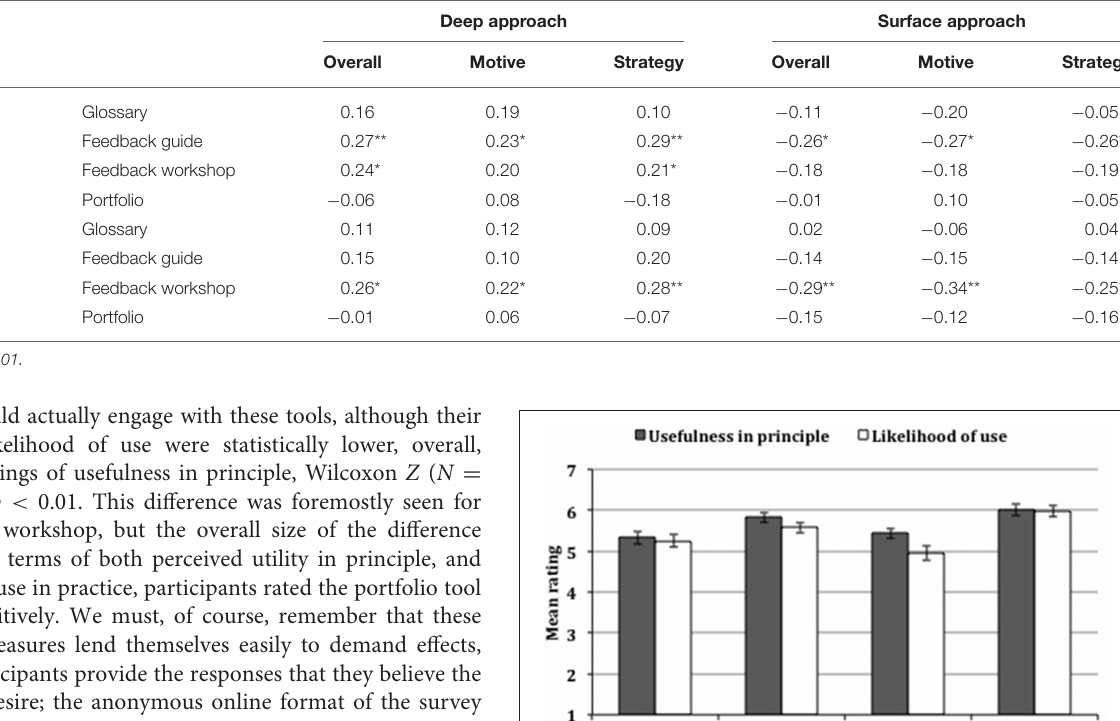
TABLE 2 | Spearman correlations between participants’ reported approaches to learning, and their perceptions of the utility and likelihood of use of each DEFT component.